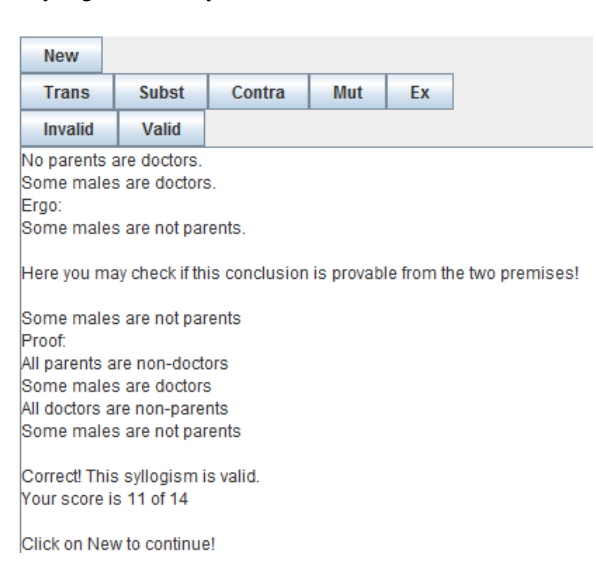
Fig. 1: eao (feraxo)